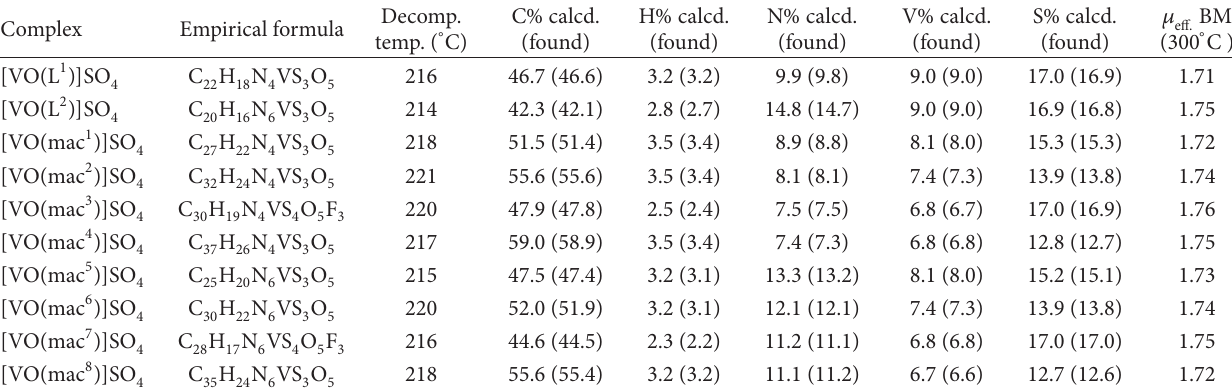
T 1: Physical and analytical data of the